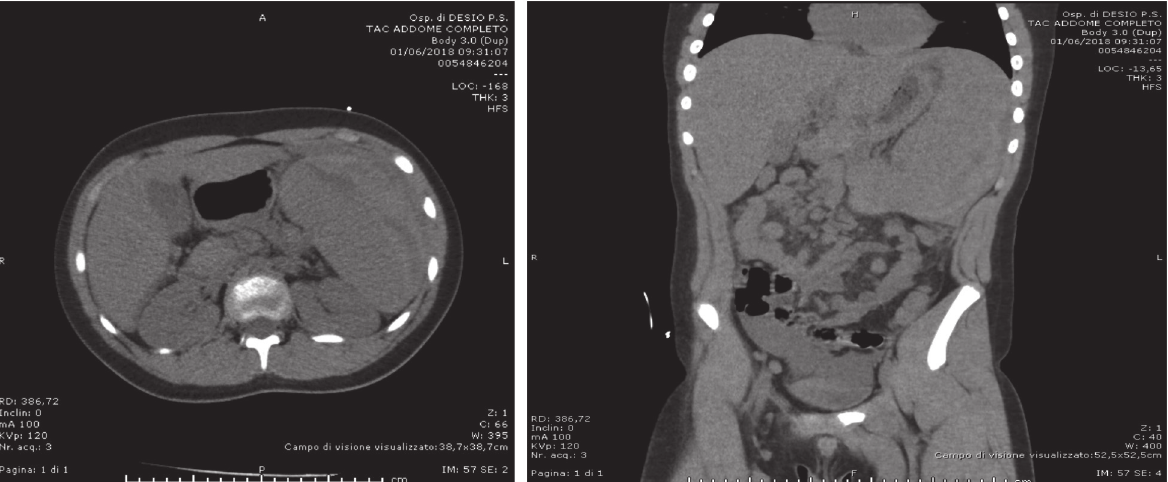
Figure 1. Computed tomographic scan of the abdomen showing splenomegaly, splenic linear laceration, intraparen- chimal hematoma in lower pole, and perihepatic, perisplenic and pelvic free